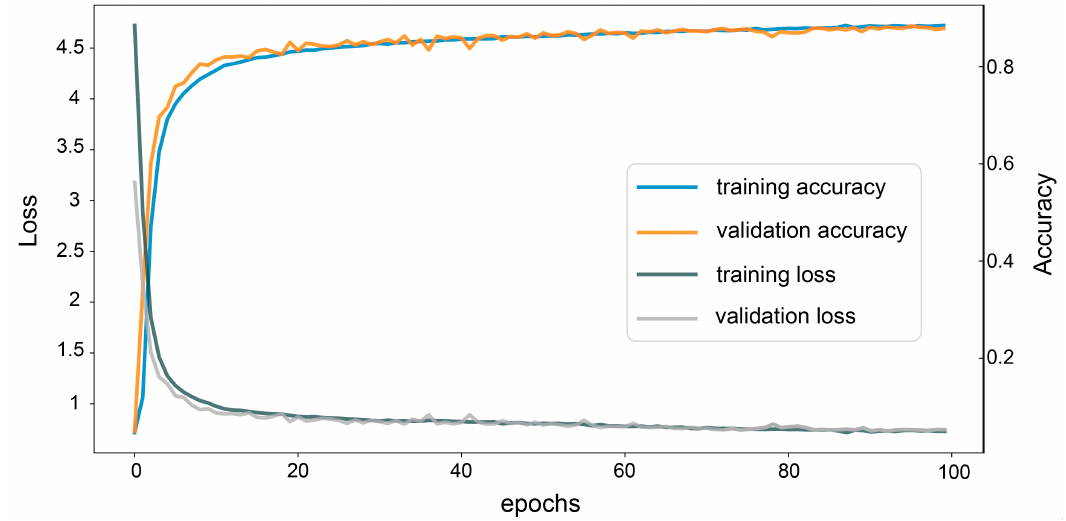
Figure 6. Learning curves for the accuracy and loss of the model for the training and validation set.